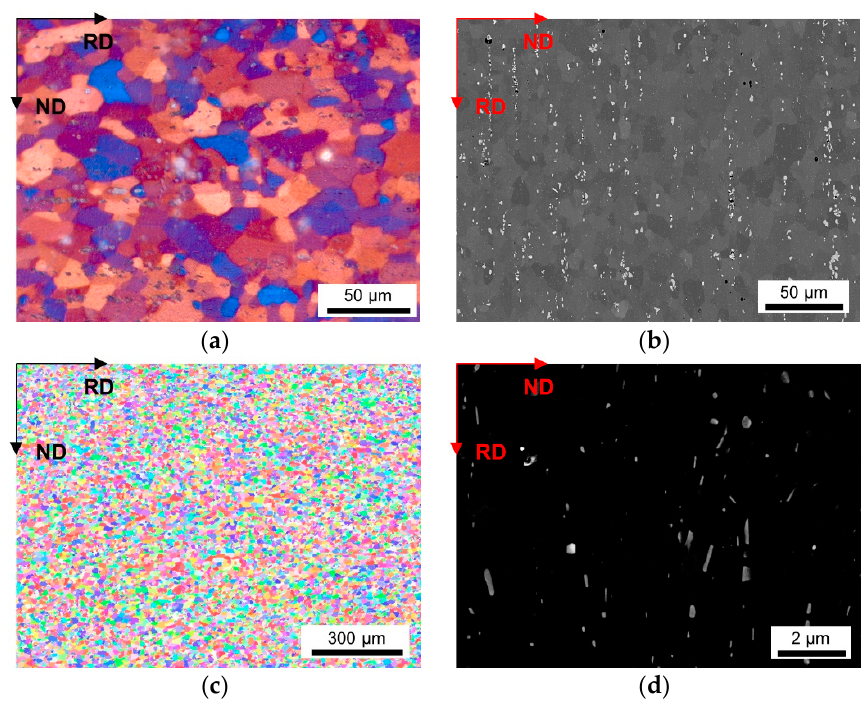
Figure A25. Microstructure of the soft annealed HFe-HMn cast under S-C conditions, homogenized at 550 °C and cold rolled to a CRD of 35%. ( a ) LOM. ( b ) BSE image. ( c ) EBSD IPF map in RD–ND plane. ( d ) BSE micrograph showing dispersoids.